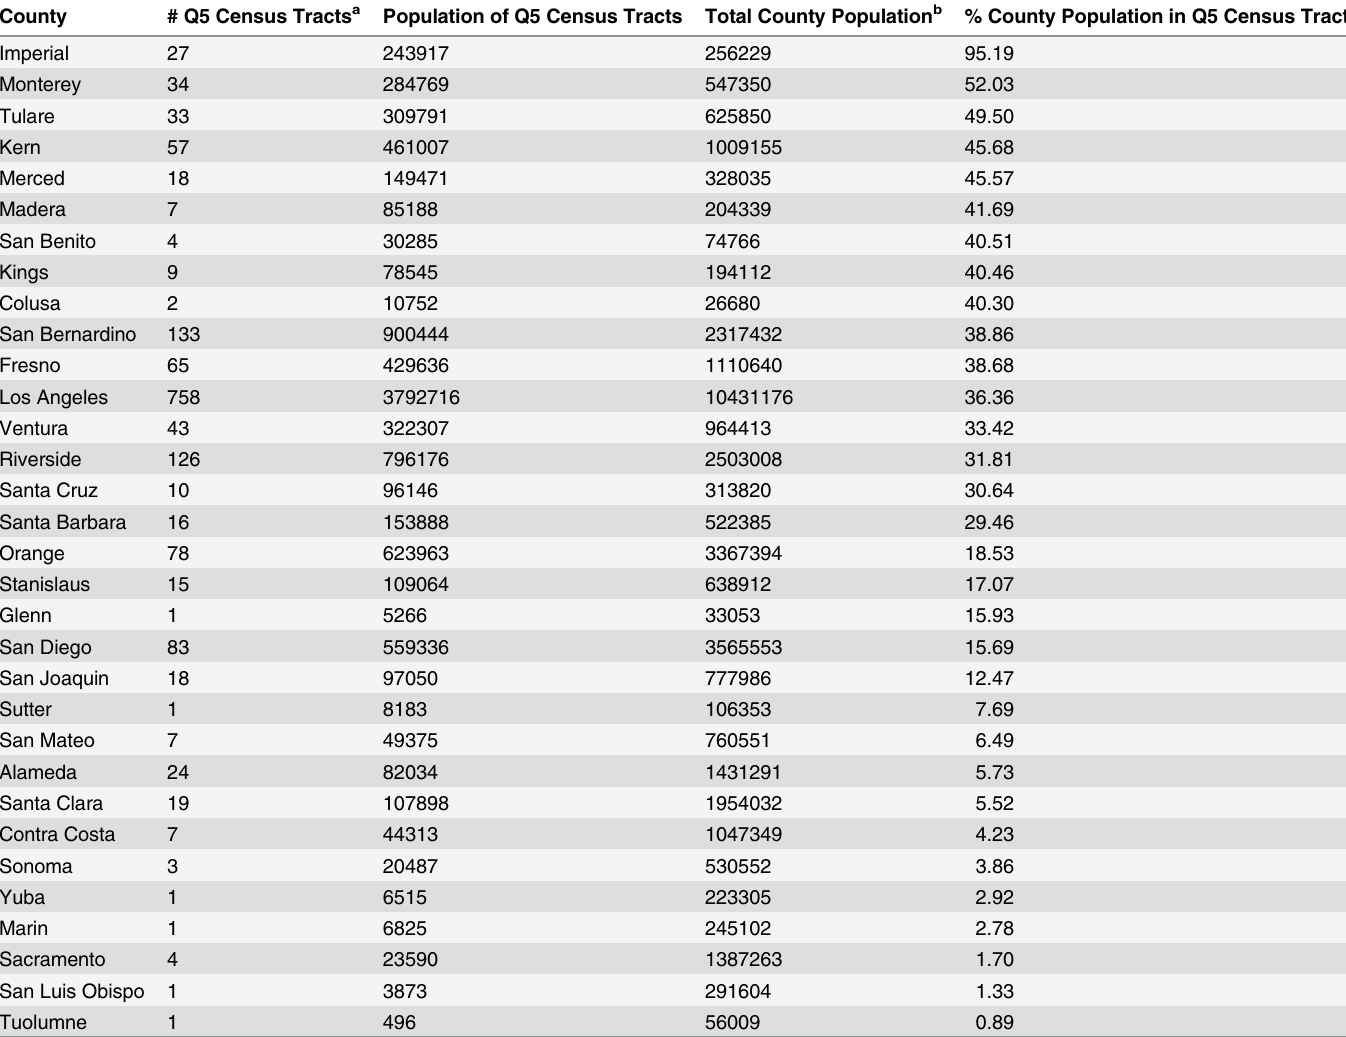
Table 2. Counties with at least one Census Tract in the highest quintile of Total